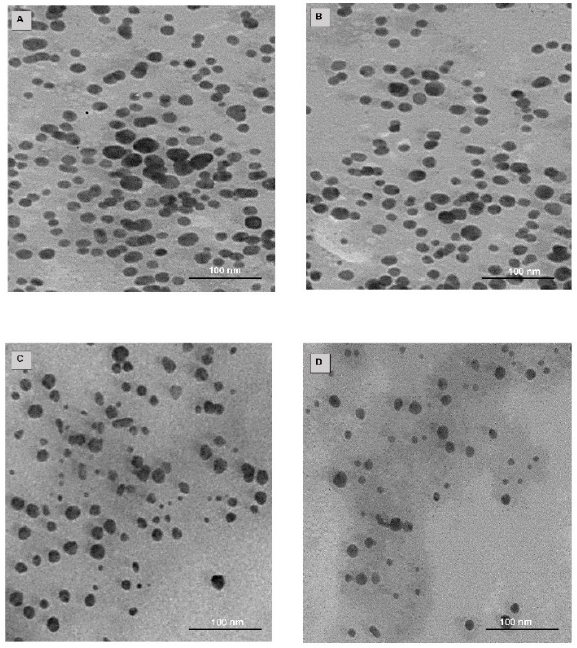
Figure 4. TEM images of nanoparticles: ( A ) AuNPs, ( B ) AuNP-BA, ( C ) T-Au-PEG-BA, ( D ) T-Au- [PLL-g-PEG]-BA.